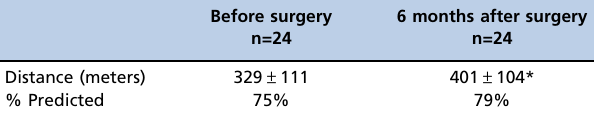
Table 4 - Distancetraveled on ISWT before and after bariatric surgery.